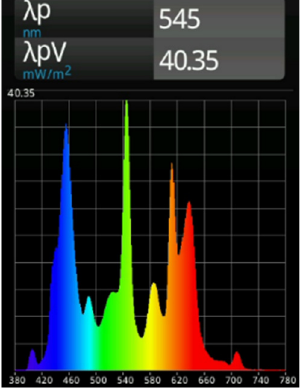
Figure 8. Spectral power distribution of the light impinging on the surface of the train with the ambient room lighting turned on.